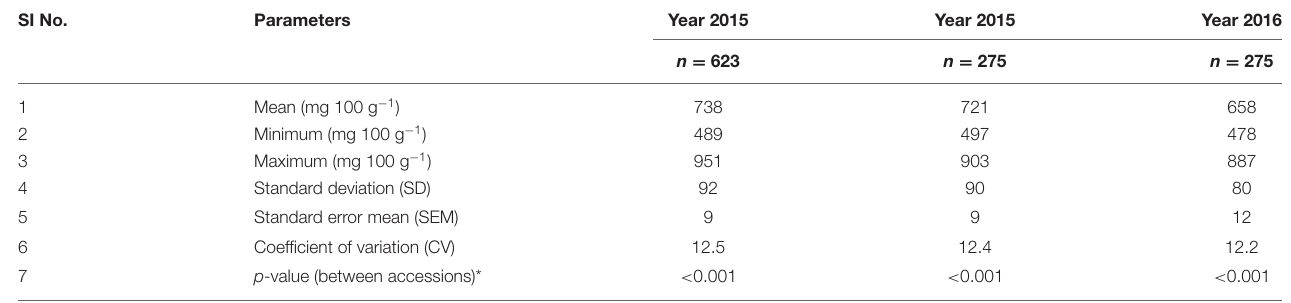
TABLE 2 | Descriptive statistics for GPA content in finger millet accessions across generations. SI